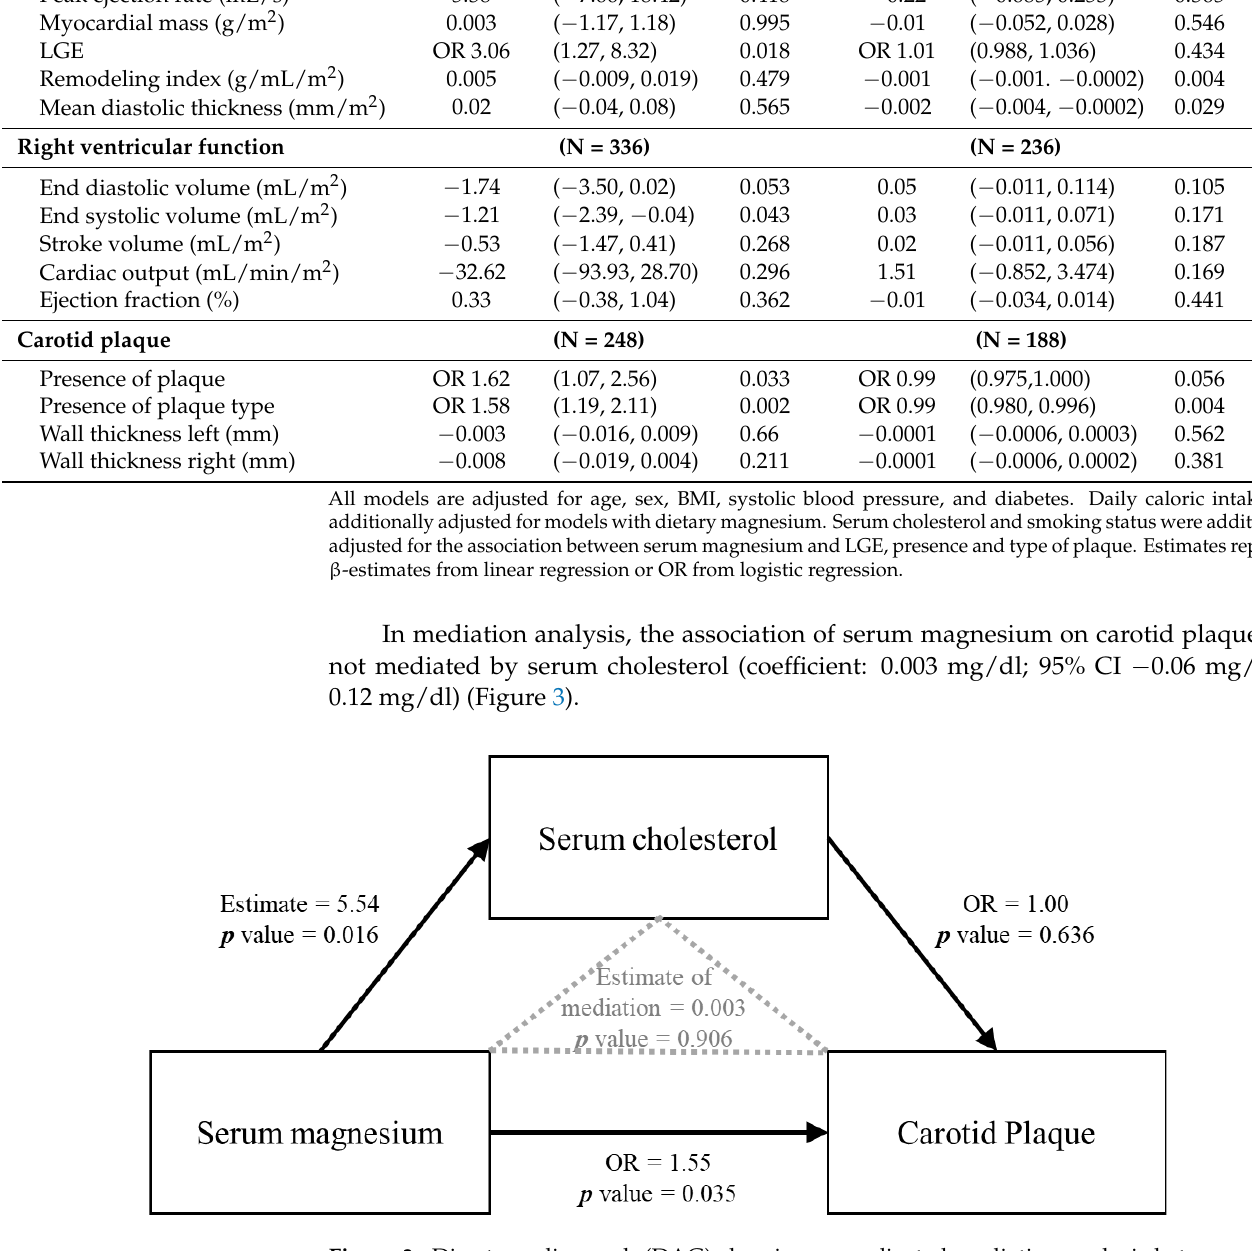
Figure 3. Direct acyclic graph (DAG) showing non-adjusted mediation analysis between serum magnesium, serum cholesterol, and carotid plaque.